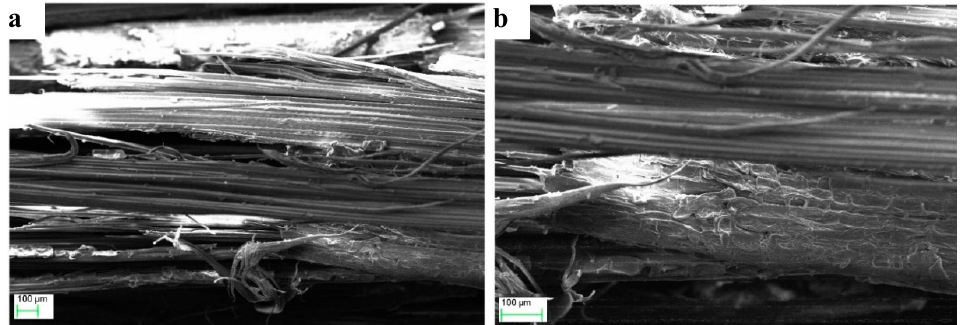
Figure 5. Microstructure of the surface of the single-cellulosic Buluh semantan strips after soaking for 18 h in 8 wt.% NaOH showing in ( a ), and ( b ) damage the strength of fibers in di ff erent magnification.